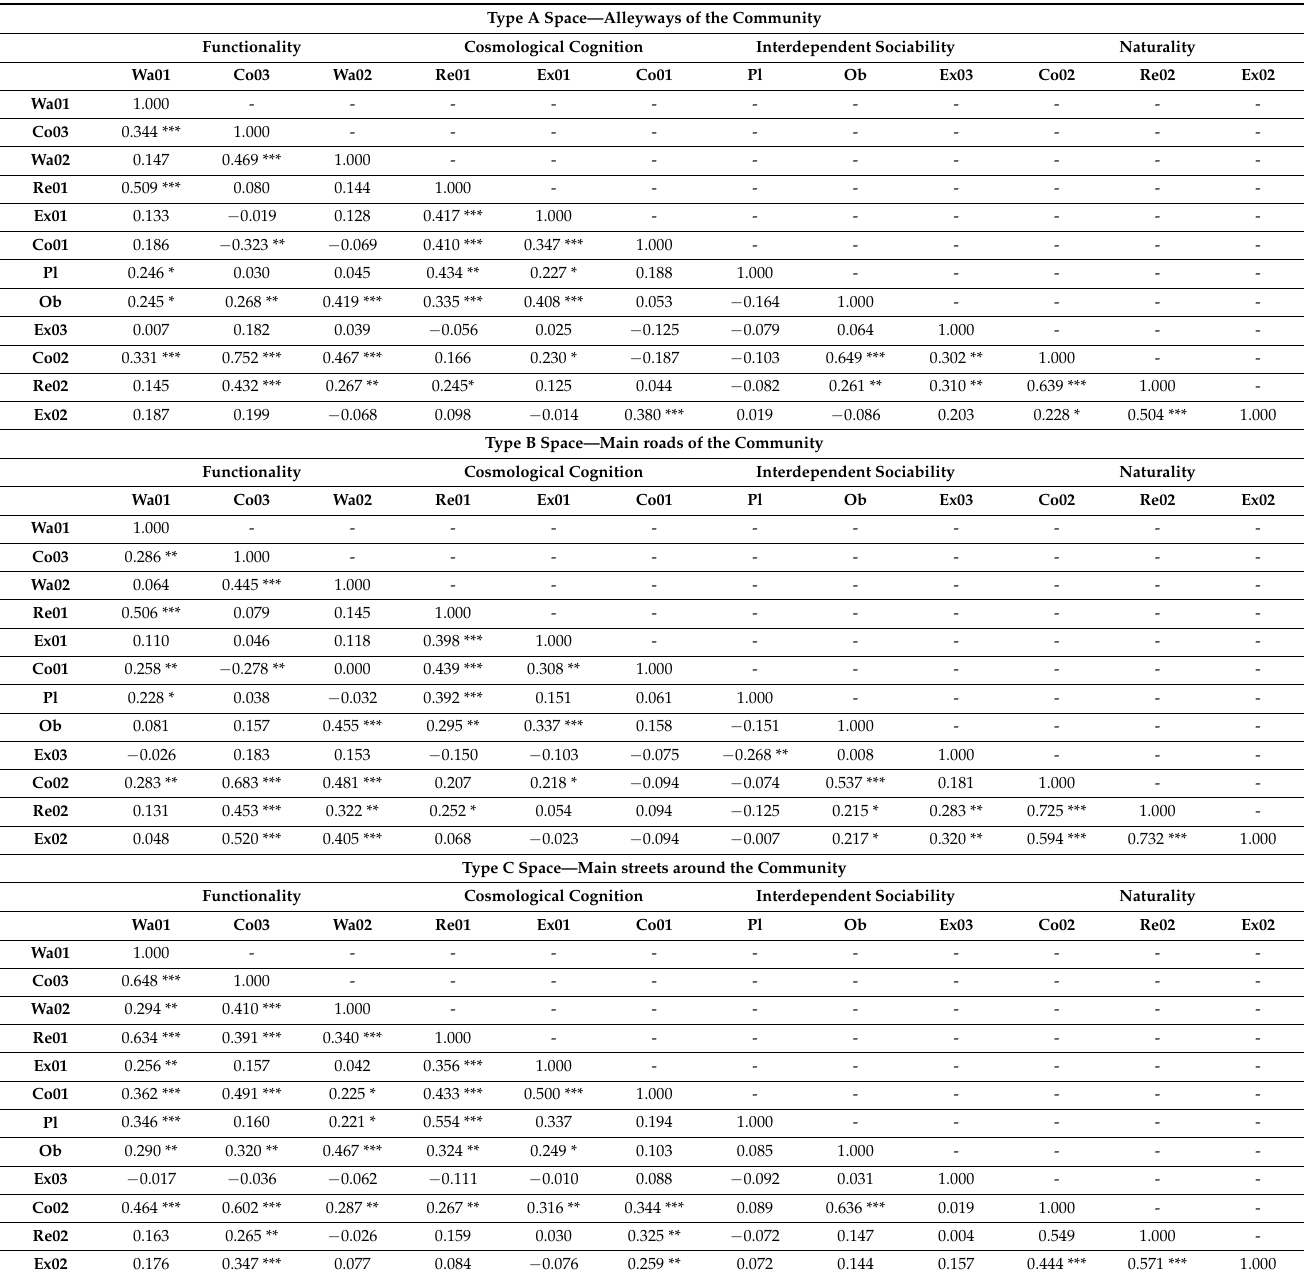
Table 10. The correlation matrices for determining the relevance of indicators in the three types of